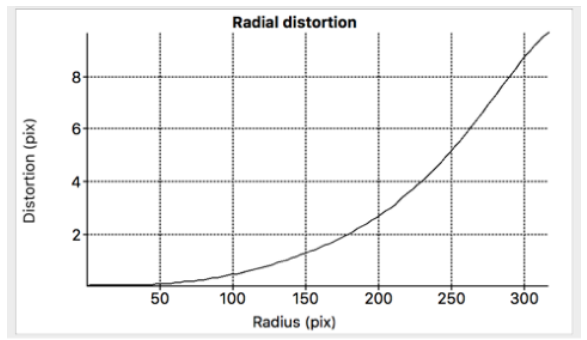
Figure 6. Radial distortion of camera calibration